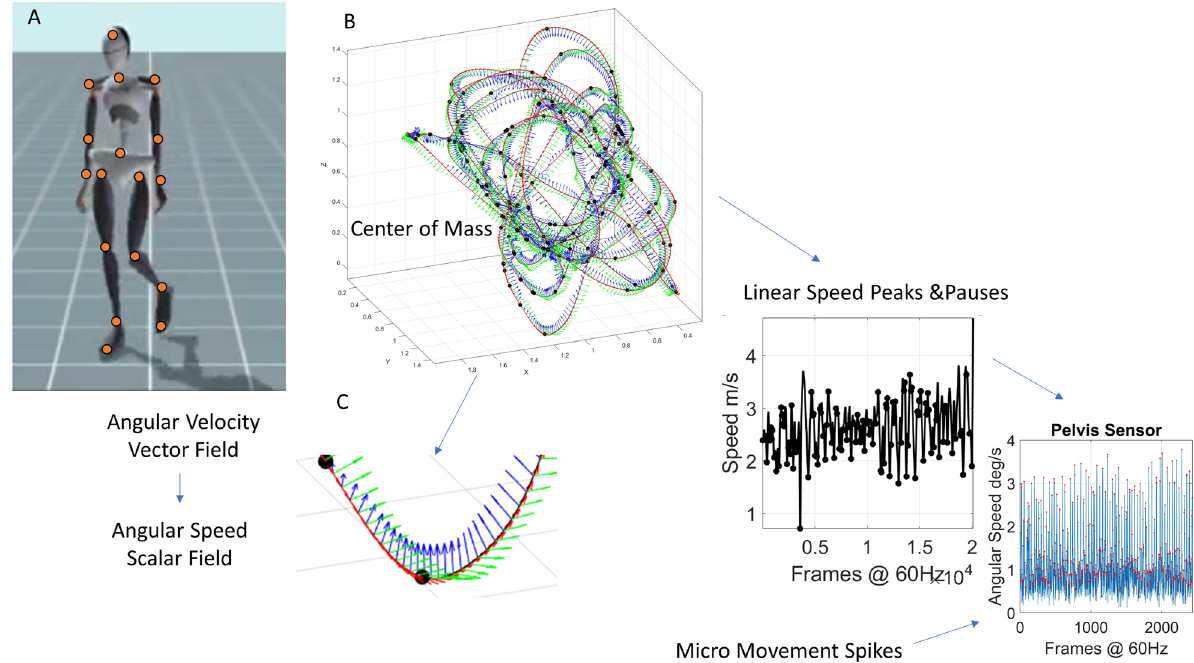
Figure 12. Methods figure. ( A ) Data acquisition using a grid of wearable sensors calibrating position and orientation in real time and sampling changes of position and orientation in time, internal sampling rate 1 kHz, output 60–120 Hz (specs at xsens Mtw Awinda, https:// www. xsens. com/ produ cts/ mtw- awinda). ( B ) Center of Mass trajectories (m) in 3D parameterized using the Frenet-Serret frame to study geometric aspects of the curve. ( C ) Linear speed used to mark pauses and peaks along the curve, thus allowing us to express behavioral landmarks along other kinematics parameters such as the angular speed quantifying bodily rates of 23 joints’ rotations. The MMS are derived from the fluctuations in angular speed amplitude. Red dots mark peaks (transitions of speed slope from positive to negative).